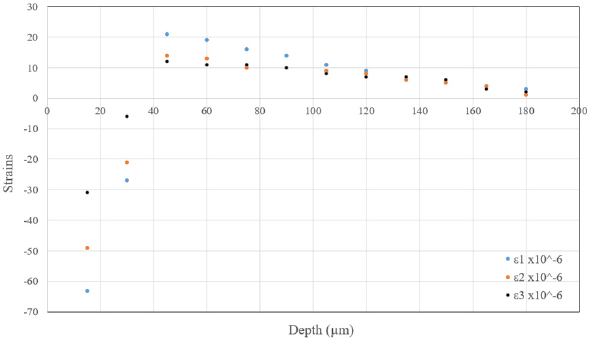
Figure 7. In-depth residual strain distributions in the cutting direction.